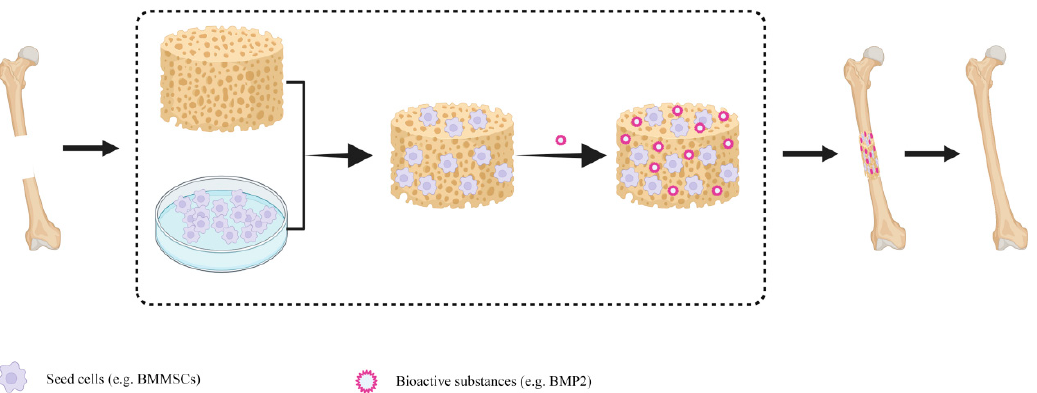
Figure 1. Schematic diagram of tissue engineering bone composition and repair of bone defect. The cells were cultured on scaffolds, and then some bioactive substances such as cytokines were added. The tissue-engineered bone was implanted into the bone defect, and then the new bone was generated by degradation of the scaffold material, and the bone defect was repaired. BMMSCs-Bone marrow mesenchymal stem cells; BMP2-Bone Morphogenetic Protein 2.